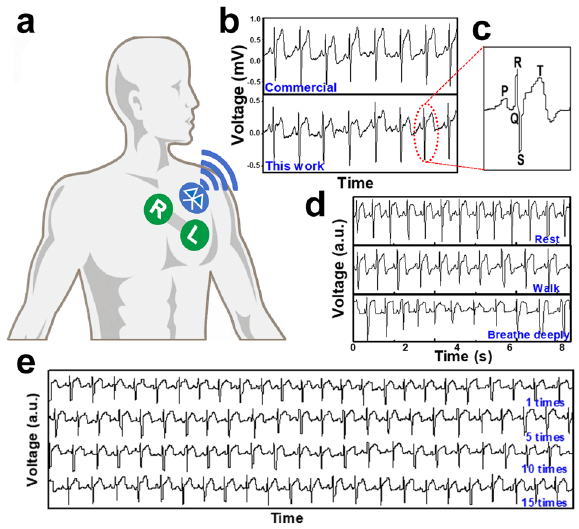
Fig. 5 PPG hydrogel as sensor patch for ECG detection. a Schematic illustration monitoring ECG signals with portable sensor and transmitting via Bluetooth. b ECG signals collected from the PPG hydrogel and a commercial hydrogel. c Characteristic peaks of ECG collected by PPG hydrogel. d , e ECG signals collected with different behaviors and repeated paste